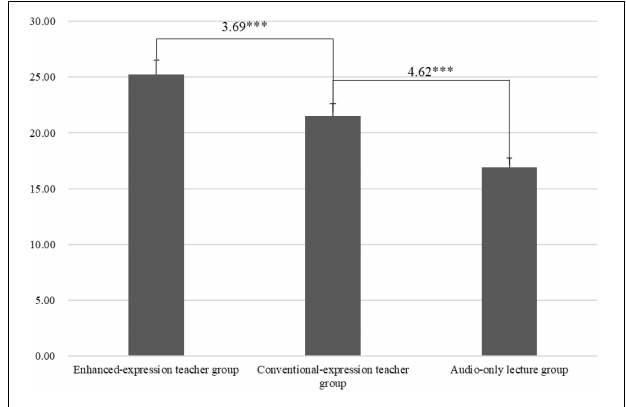
FIGURE 2 | Participants’ perceived social presence in the three groups. The 3.69 and 4.62 represent the Mean difference, ∗∗∗ represents that the mean difference is significant at the 0.001